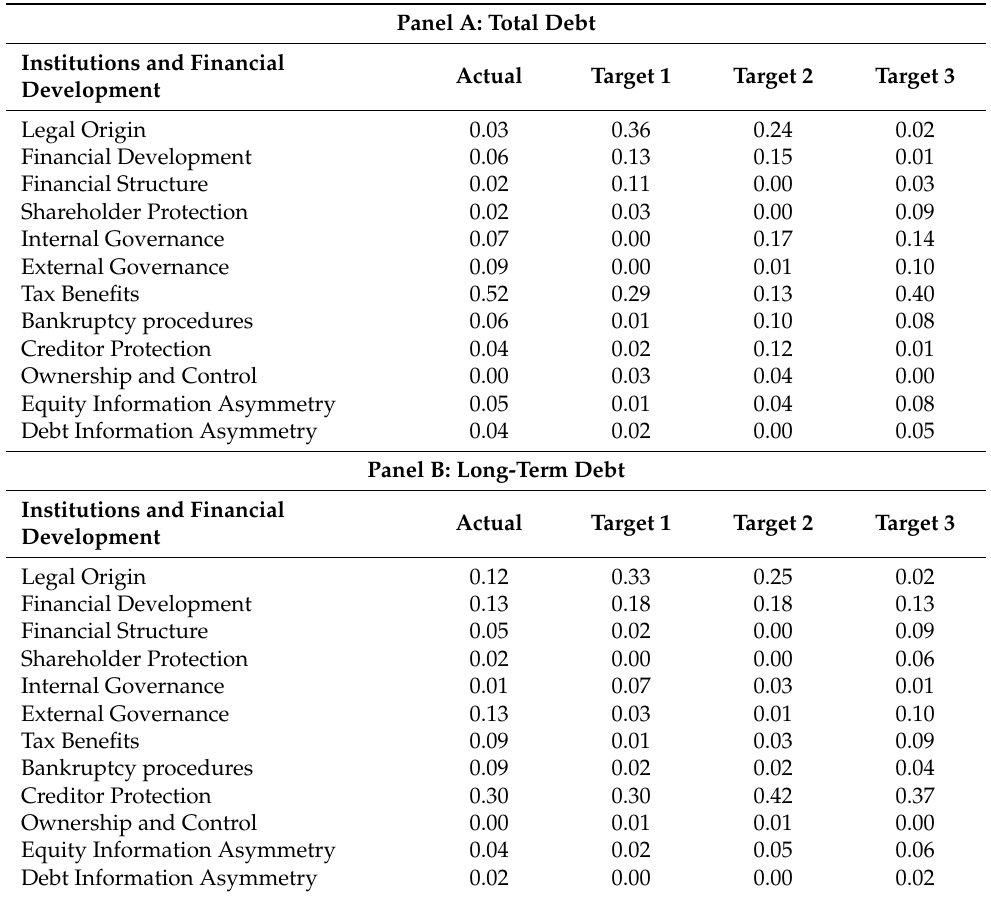
Table 4. Variance decomposition analyses of leverage: financial development of